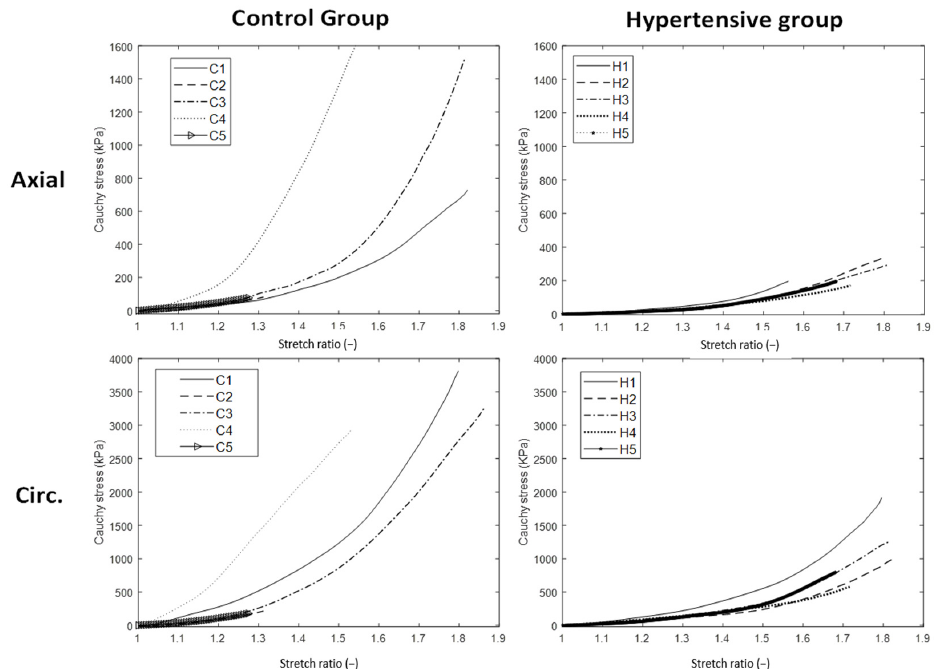
Figure 4. Stress-stretch curves for the control (first column) and hypertensive (second column) aortic samples in the axial (first row) and circumferential (second row) directions. For the range of tested specimens, a stiffer circumferential response is evident for both control and hypertensive groups. Comparing the direction-wise mechanical response between the control and hypertensive groups, higher stresses for the same stretch ratios were observed in the control samples compared to the hypertensive group. The levels of maximal circumferential stresses are approximately 2.5× of the maximal axial stresses. Next, for better demonstration and comparison, stress limits were differently set on axial and circumferential stress-stretch axes (1600 and 4000 kPa, respectively). Table 3. Calculated values of tangent moduli (E init , E fin ) for the control and hypertension groups in axial and circumferential directions. The mean and standard deviation of the data groups are also provided.